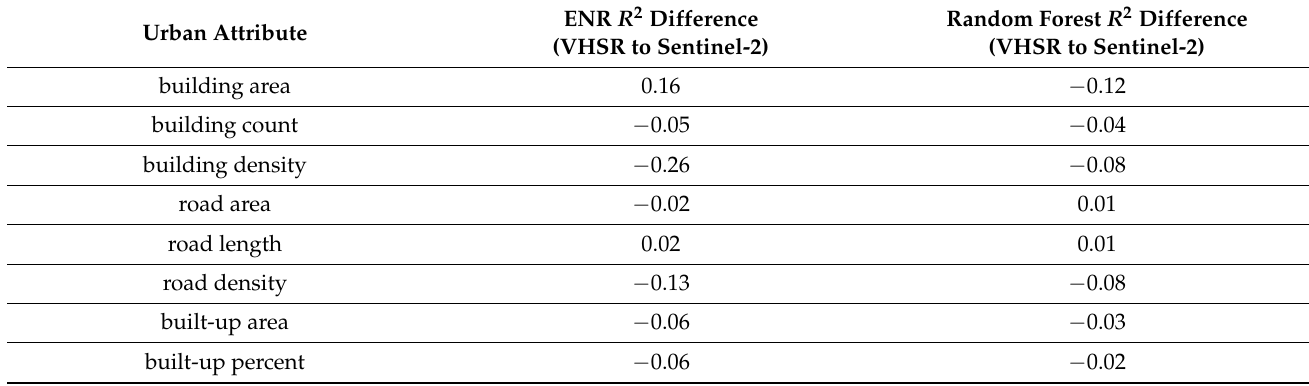
Table 13. Impacts of degrading spatial resolution from very-high-spatial-resolution (VHSR) to Sentinel-2 data on urban attribute model performance. The differences in out-of-sample R 2 between the VHSR and Sentinel-2 models were calculated. A negative value indicates the out-of-sample R 2 decreased (a decrease in predictive power) from the VHSR model to Sentinel- 2 model; a positive value indicates the out-of-sample R 2 increased (an increase in predictive power) from VHSR to Sentinel-2. Differences may not correspond to actual R 2 values due to rounding. Abbreviation: ENR, elastic net